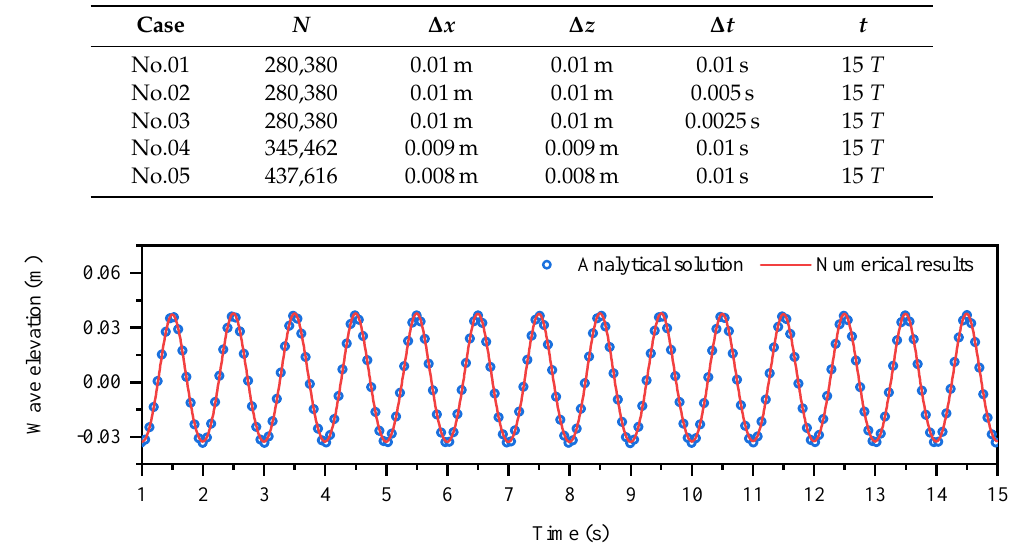
Figure 4. Evolutionary profile of surface elevation at wave gauge G1 with λ = 2.0m and wave height H = 0.07m.